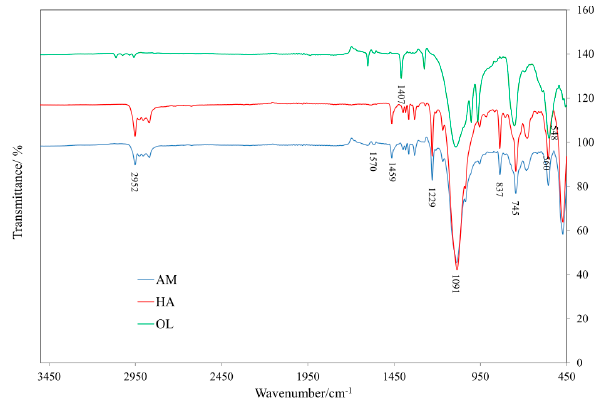
Figure 6. FTIR spectra of studied POSS.